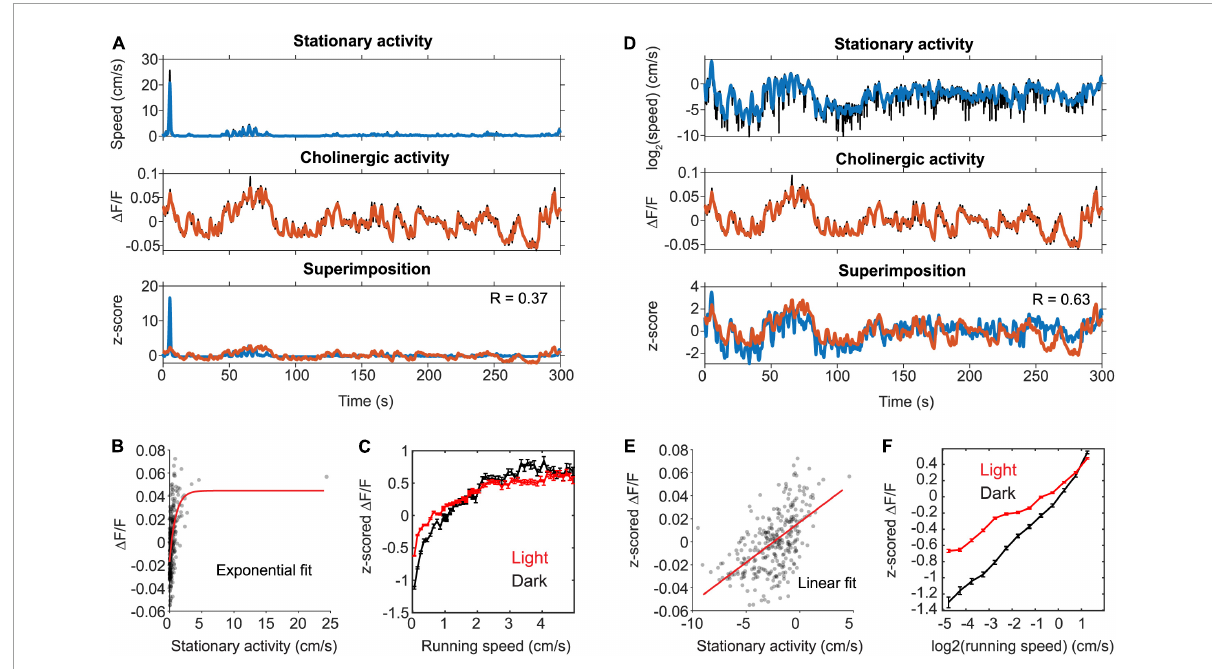
FIGURE2 The activity of cholinergic neurons is linearly correlated to neck movements during stationary behavior. (A) Data on the speed of neck movements during stationary behaviors and activity of cholinergic neurons in the MSDB measured via fiber-photometry for one example session, in which the mouse remained stationary (running speed < 3-cm/s) for more than two thirds of the session length. Note the high fluctuations in the fiber photometry signal during stationary activity. (B) Scatter plot of cholinergic activity vs. running speed; data points were sampled in 1-s intervals from the time series data shown in (A). Red line shows the exponential fit to the data. (C) Speed tuning curves of cholinergic activity comparing data from light (red, data from 13 sessions, 3 mice) and darkness (black, data from 3 sessions, 2 mice) sessions. Data show mean ± s.e.m. of speed-binned data with a bin width of 1-cm/s. (D) Same data as in (A) but now plotting the logarithm of neck movement speed. (E) Scatter plot of cholinergic activity vs. the logarithm of the animal’s neck movement speed; data points were sampled in 1-s intervals from the time series data shown in (D). Red line shows the linear fit to the data. (F) Tuning curve shows cholinergic activity as a function of the logarithm of neck movement speed; data show mean ± s.e.m. of binned data with a bin width of 0.1; data on light sessions (red) from 13 sessions, 3 mice; data on darkness sessions (black) from 3 sessions, 2 mice; no significant difference between light and darkness sessions was found (see Table 3 for statistics). R, Pearson’s correlation